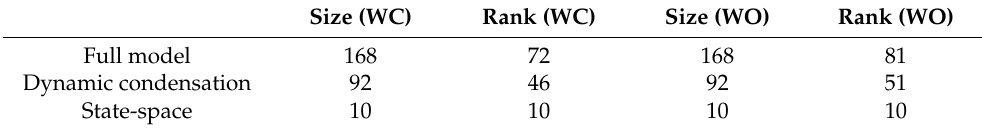
Figure 7. Time domain impulse response diagram before and after model reduction. Table 3. Judgment indexes of controllability and observability before and after model reduction.